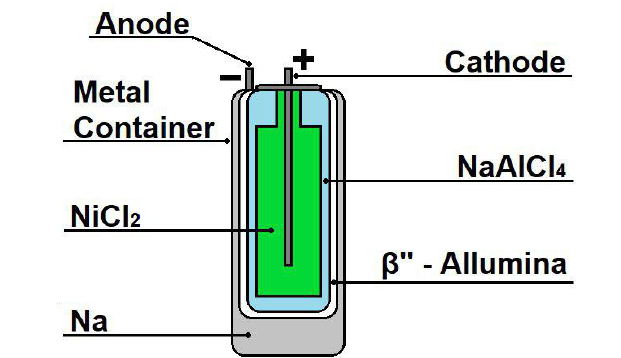
Figure 2. Schematic representation of sodium metal halide cell.